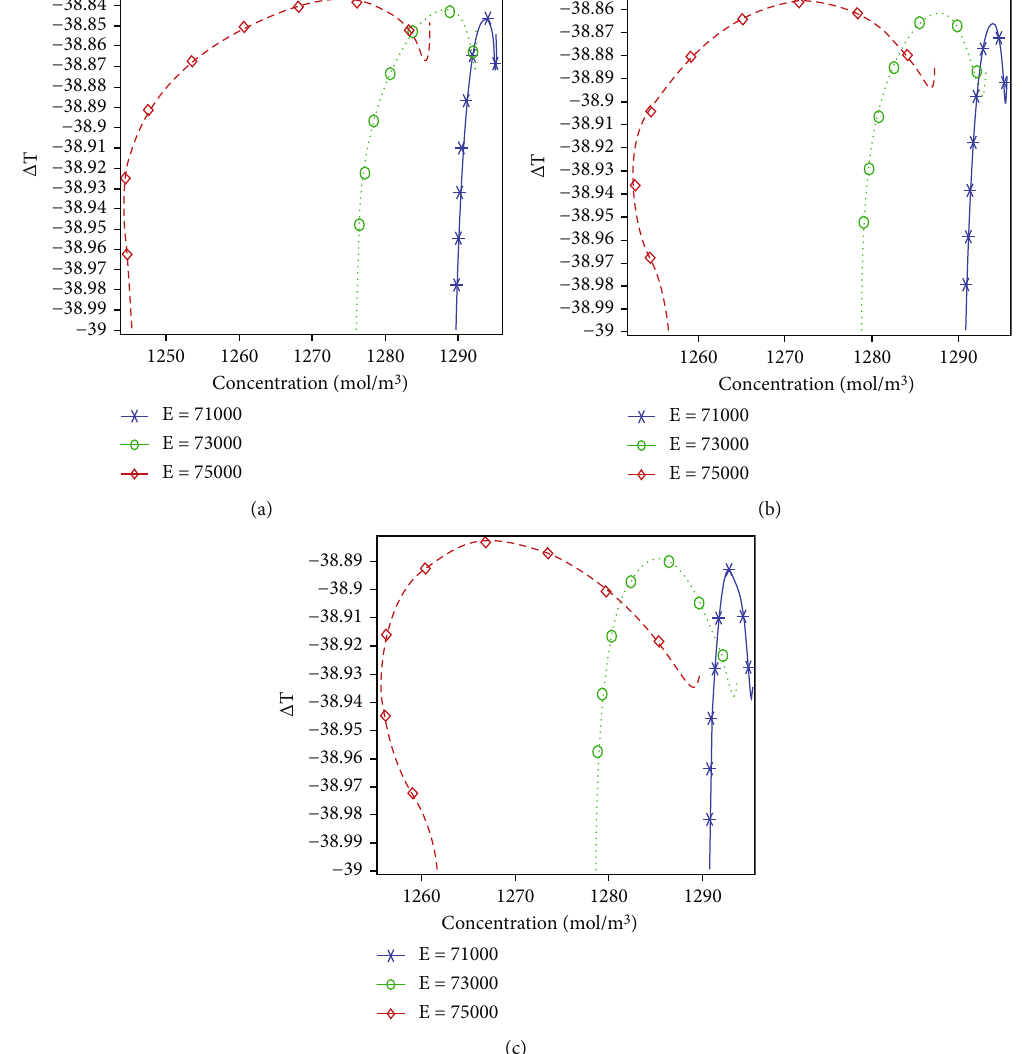
Figure 11: Change in the temperature at downstream along the backward step channel against the concentration of calcium hydroxide at (a) Re = 100 , I : C = 3 % , a = 0 : 5 ; (b) Re = 100 , I : C = 3 % , a = 0 : 6 ; and (c) Re = 100 , I : C = 3 % , a = 0 : 7